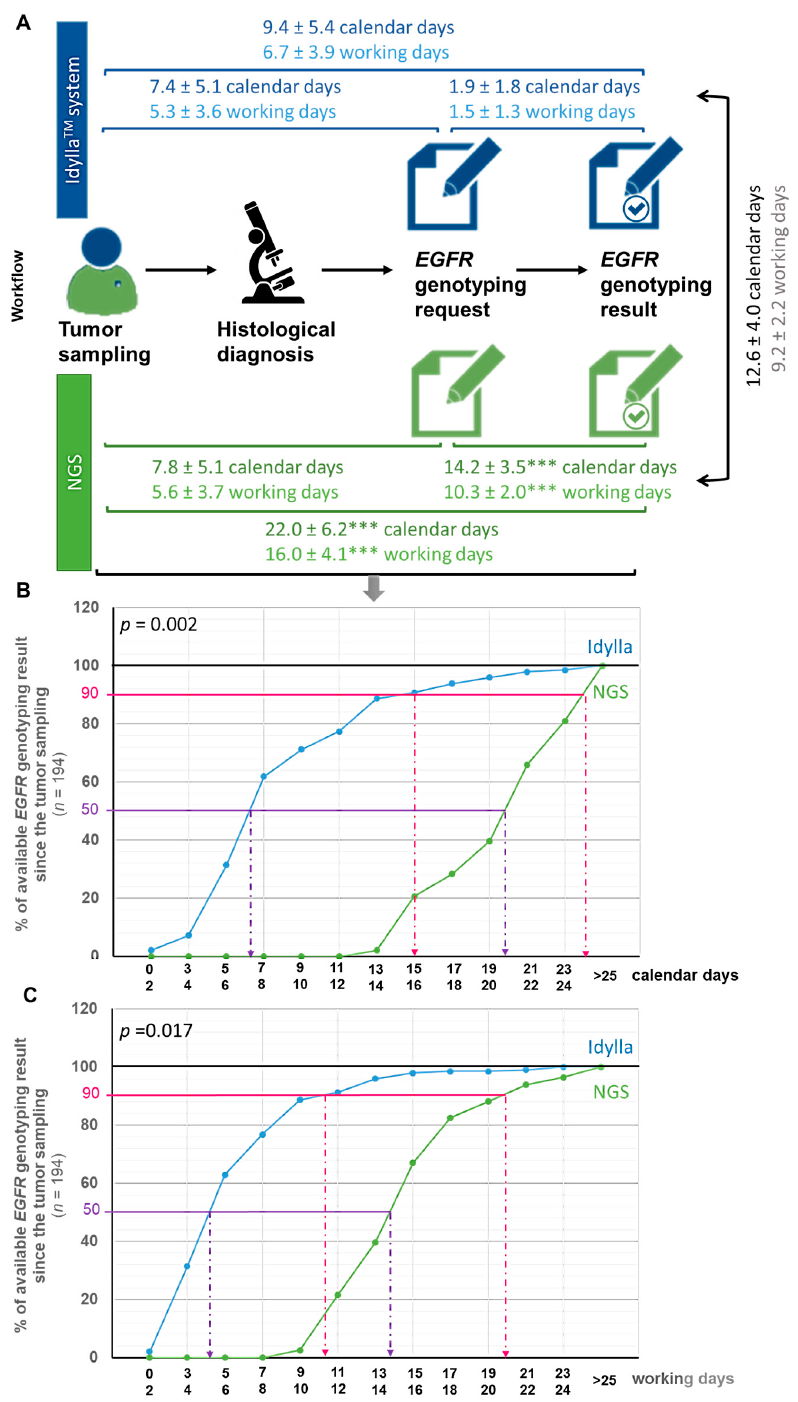
Figure 2. Turnaround time from the tumor sample to the initiation of treatment according to the NGS or Idylla TM method. ( A ) Workflow illustrating delays between each step toward the communication of EGFR genotyping result in calendar or working days (mean ± SD). Delays according to the Idylla TM system or NGS assay was tested using a t -test (*** p < 0.001 when compared in the same timeframe to the Idylla TM method). ( B , C ) Monitoring the availability of EGFR genotyping results by the Idylla TM or NGS technique from tumor sampling in calendar days ( B ) or working days ( C ). The influence of the “technique” variable (Idylla TM or NGS) on the time required to deliver EGFR genotyping result was evaluated by a two-way (techniques and time) analysis of variance (ANOVA), followed by a post-hoc Bonferroni test (GraphPad Prism version 8.0.0 Software, San Diego, California, USA).